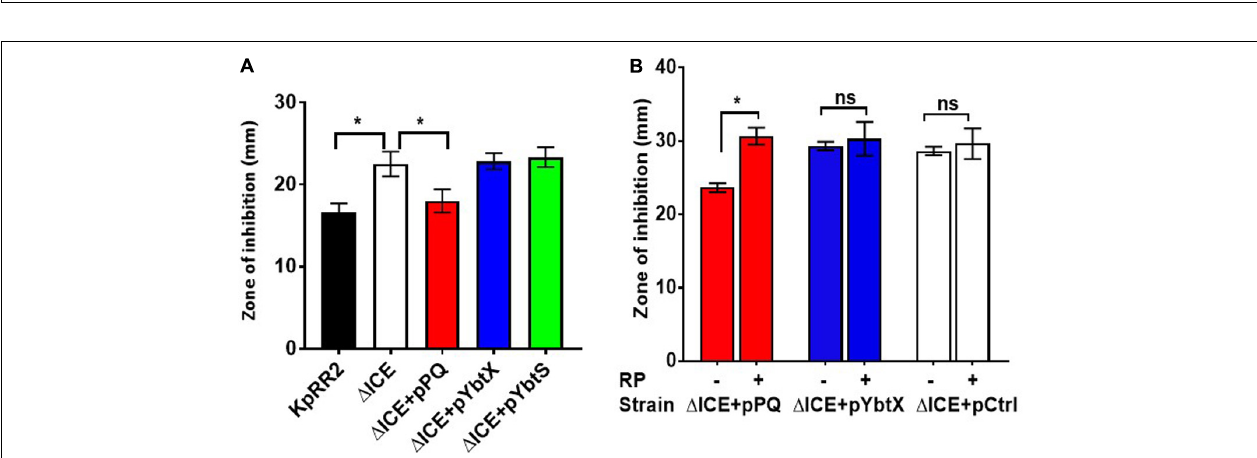
FIGURE 5 | The yersiniabactin importer YbtPQ reduced antimicrobial susceptibility of K. pneumoniae ICEKp mutant and the effect of YbtPQ was reversed by reserpine. A The enhanced trimethoprim susceptibility (larger zone of inhibition) of mutant (cid:49) ICE was fully complemented by plasmid pPQ, encoding transporter YbtPQ. Plasmids pYbtX and pYbtS did not complement the defect of (cid:49) ICE (no significant change in zone of inhibition compared to (cid:49) ICE). Trimethoprim was used at 5 µ g per disk. B The enhanced imipenem susceptibility of mutant (cid:49) ICE was fully complemented by plasmid pPQ, encoding transporter YbtPQ, but not by the vector control, pCtrl. The effect of plasmid pPQ on imipenem susceptibility was reversed by the addition of reserpine (RP) 50 µ g/disk). Data are the mean and standard deviation of at least three replicates. *indicates p < 0.05 using Student’s t test. The effect of plasmid YbtPQ on antimicrobial susceptibility was also tested with additional antimicrobials ( Supplementary Figure 2 ) and the effect of YbtPQ on antimicrobial susceptibility in the presence/absence of reserpine was additionally tested by MIC assay ( Table 2 ).